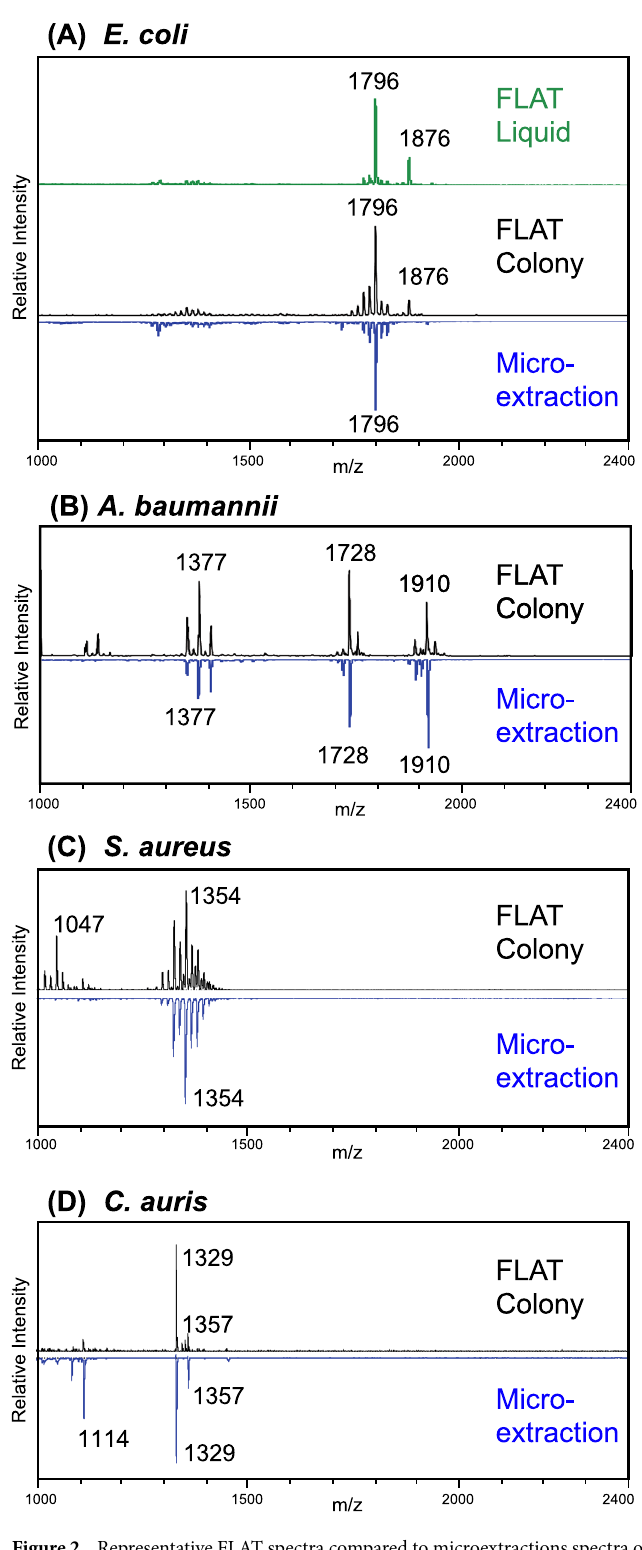
Figure 2. Representative FLAT spectra compared to microextractions spectra of the same strain. ( A ) Escherichia coli ATCC 25922 colony smear and liquid culture via FLAT is compared to microextraction. The characteristic 1796 m/z lipid A ion 28 is observed in all spectra. Additionally, an ion at 1876 m/z is observed with FLAT, but not with microextraction. This is plausibly a lipid A ion, and may have been previously observed in E. coli 28 , but is not typically extracted via microextraction. Colony smears via FLAT are compared to microextraction in ( B ) through ( D ), with the same base peak shown for both methods for each species. ( B ) Acinetobacter baumannii SM1536. Previously reported ions 16 are observed. ( C ) Staphylococcus aureus NRS484. The pattern of ions from 1300 to 1400 m/z is highly similar in both methods. An ion at 1047 m/z in FLAT may be present at very low intensity in microextraction. ( D ) Candida auris AR0384. Two ions at 1329 and 1357 m/z are present in both spectra. An ion at 1114 m/z in microextraction may be present at low intensity in